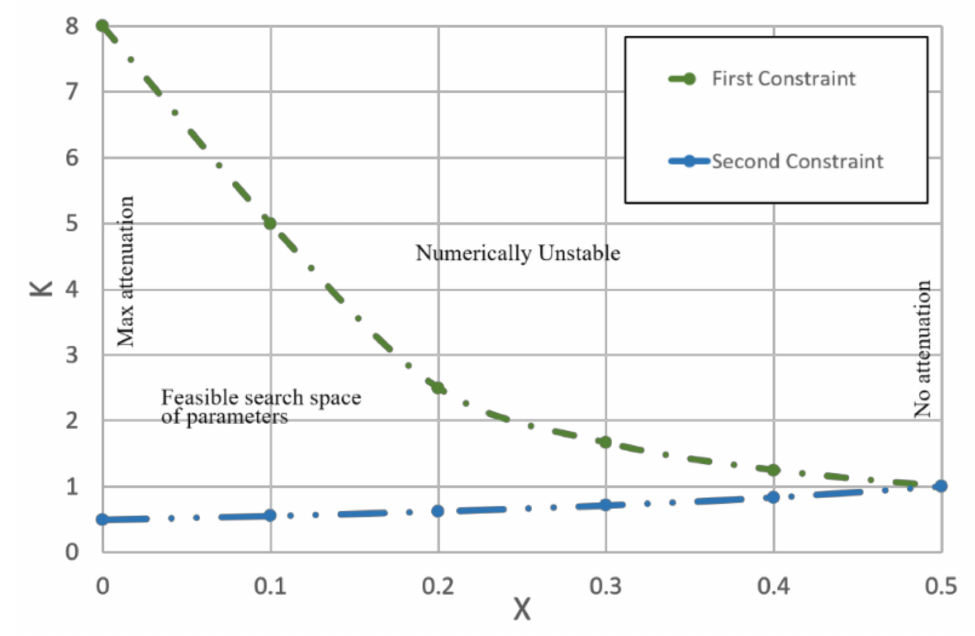
Figure 5. Feasible domain for Muskingum parameters K and X parameters based on the stabil- ity